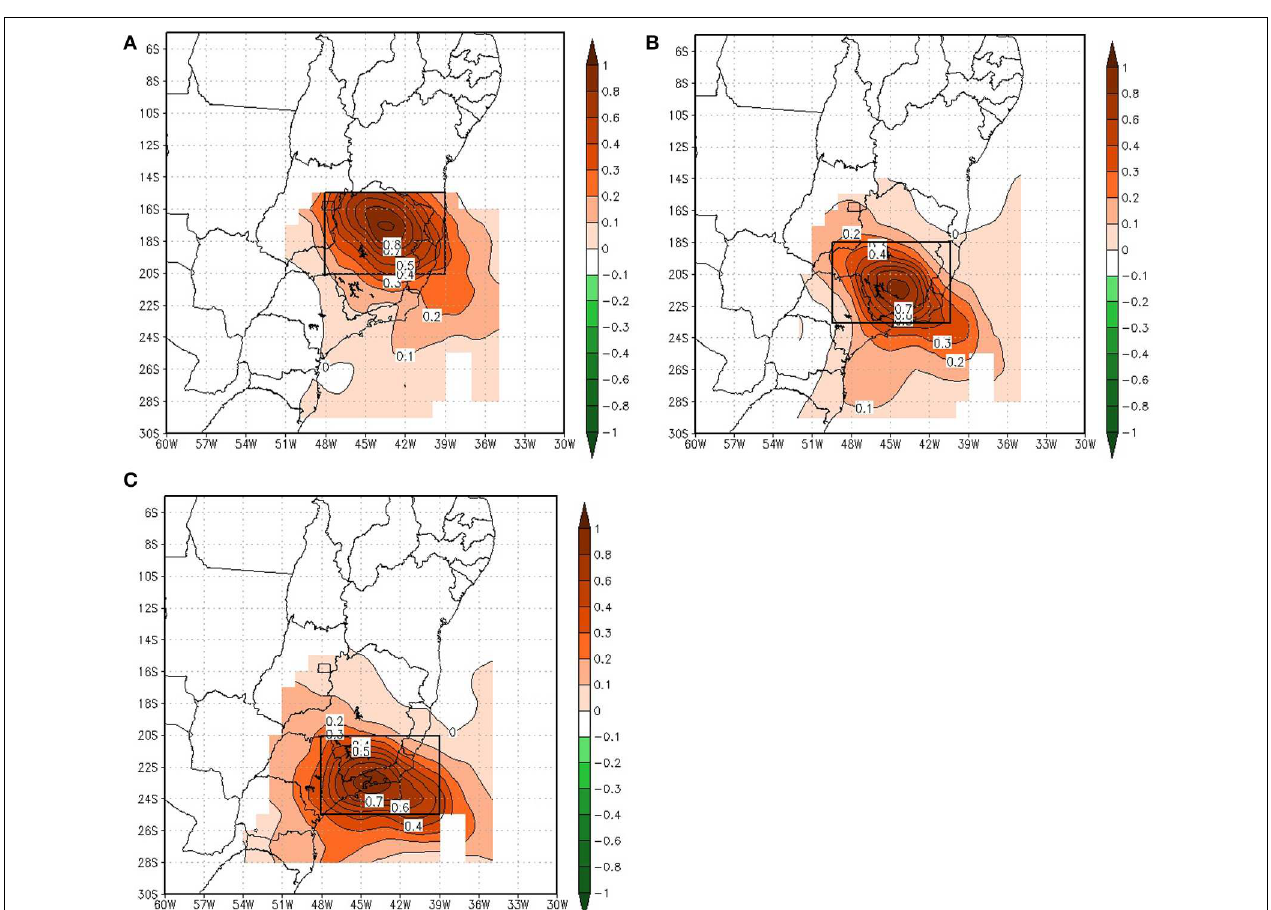
FIGURE 5 | SACZ-related variability methods using actual precipitation data (A - top left), present (B - top right) and future time RCP4.5 (C - bottom left).